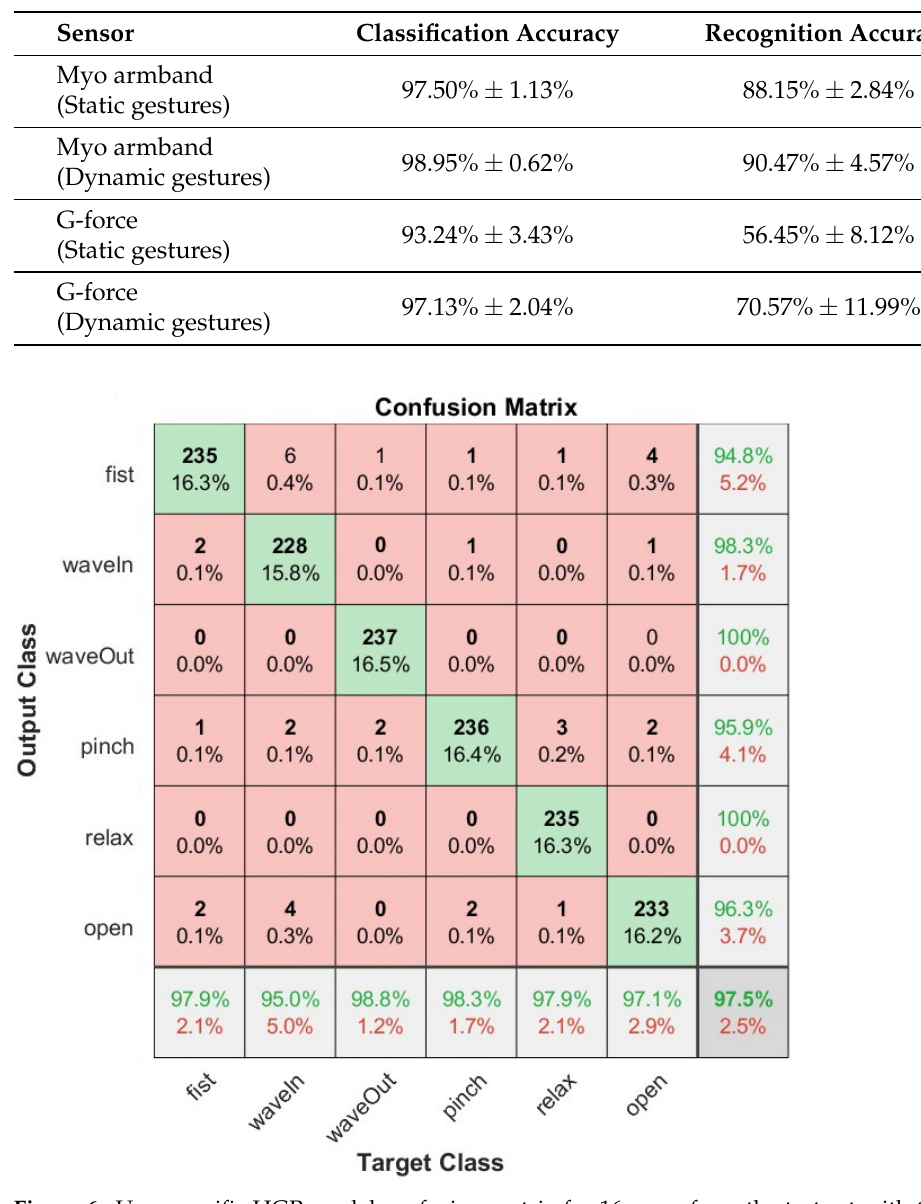
Table 4. User-specific testing results for Myo armband and G-force sensors.